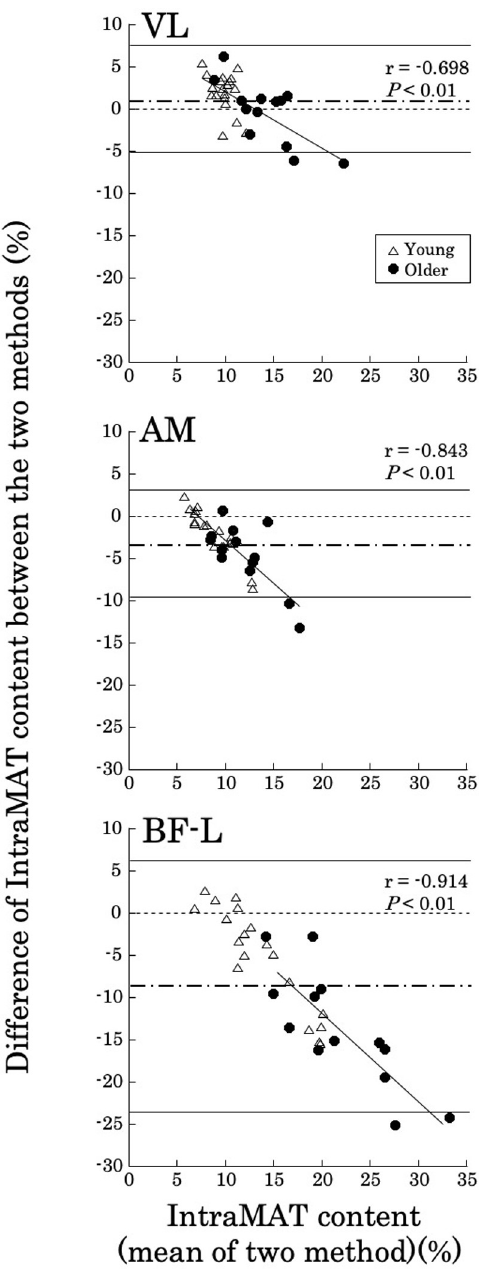
Fig 3. Bland-Altman plots demonstrating the agreement for intramuscular adipose tissue content (IntraMAT content; %) of the Vastus Lateralis (VL), Adductor Magnus (AM) and the Biceps Femoris-Long head (BF-L) between T1-weighted and 2-Point Dixon (2PD)